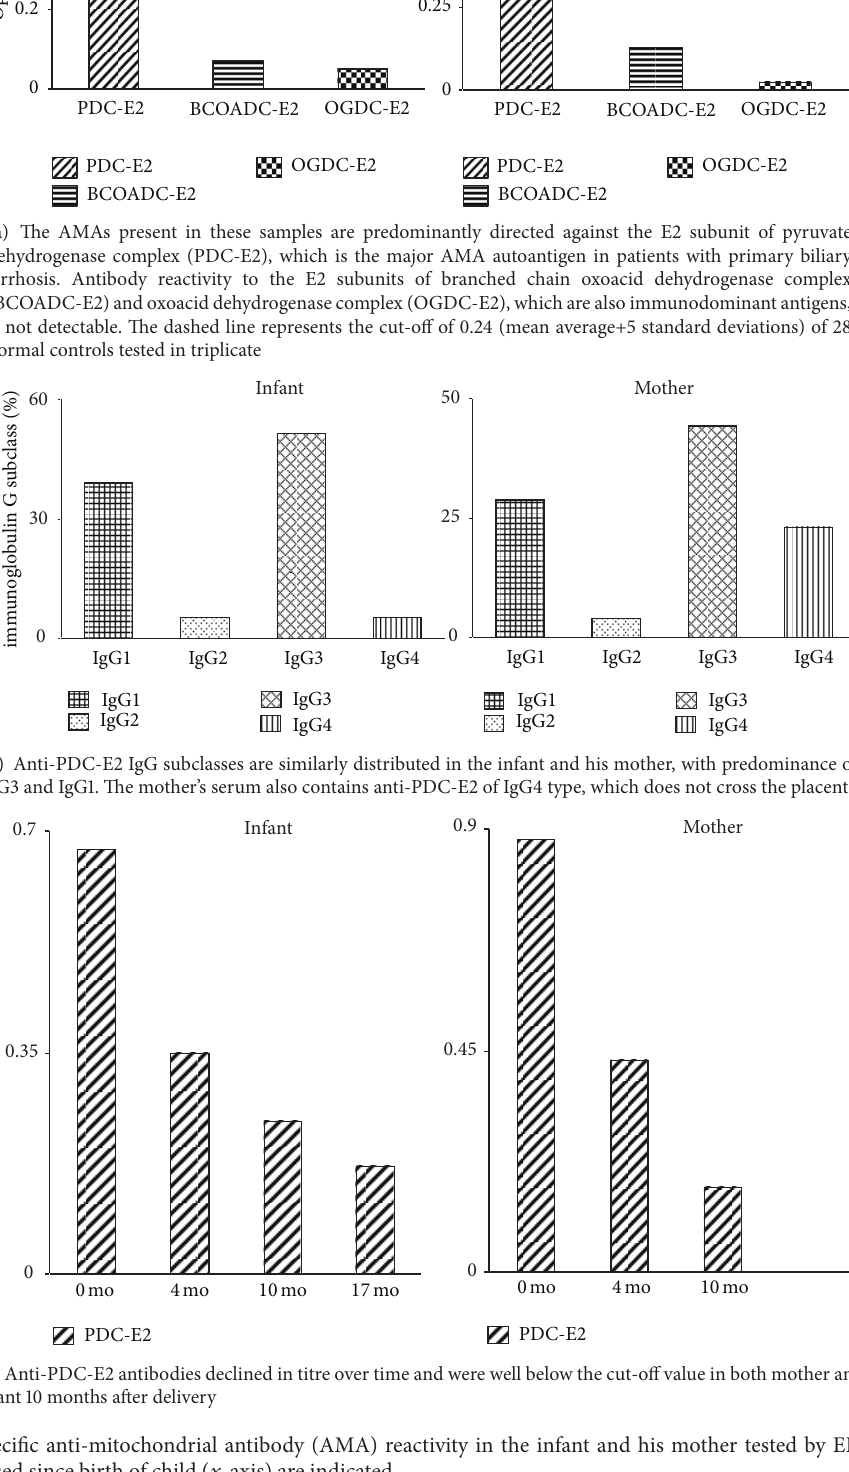
Figure 3: Antigen specific anti-mitochondrial antibody (AMA) reactivity in the infant and his mother tested by ELISA. Optical density ( 𝑦 -axis) and time elapsed since birth of child ( 𝑥 -axis) are